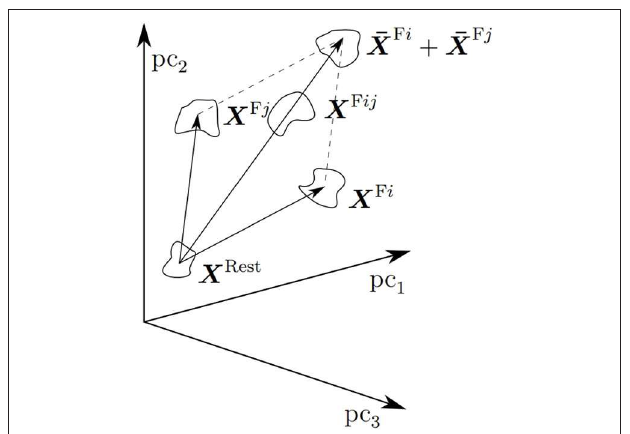
FIGURE 13 | A graphical representation of linear superposition of effects in the input space. A rest cluster X Rest , two single-action clusters X F i and X F j and the combination cluster X F ij are depicted. That linear regression can predict combined actions from single actions only, should imply that X F ij largely coincides with X F i + X F j (Reproduced with permission from Nowak,